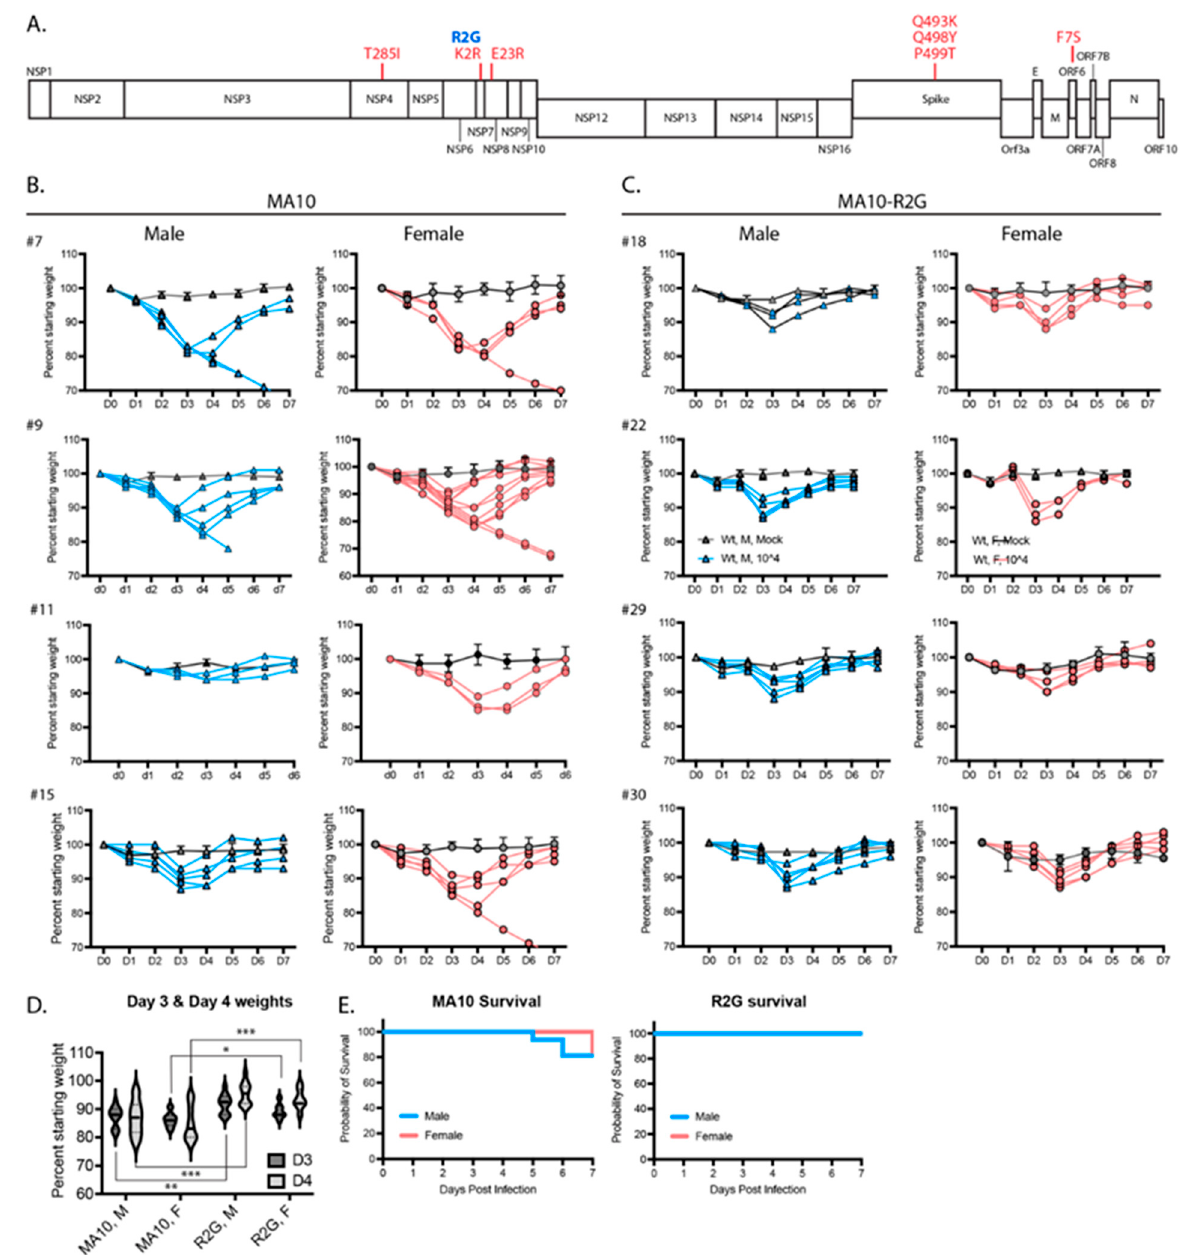
Figure 2. Comparison of SARS-CoV-2 MA10 and the R2G variant that was generated in our lab. ( A ) Schematic representation of the SARS-CoV-2 genome showing mutations found in MA10 (red) and in the R2G variant (blue) as compared to the original Wuhan isolate. ( B , C ) Weight loss in males (blue) and females (pink) infected with MA10 ( B ) or R2G ( C ). Four independent experiments are shown for each to demonstrate experiment-to-experiment variability/consistency. Data for mocks are shown as averages with 2–5 mice per cohort, while spaghetti plots are presented for each infected animal. ( D ) Violin plots of body weight for male (M) and female (F) animals three or four days post infection with either MA10 or R2G. Plots include all animals shown in ( B , C ) and significance was calculated using Welch’s t -test, where * is p ≤ 0.05, ** is p ≤ 0.01, and *** is p ≤ 0.001. ( E ) Survival curves for animals infected with MA10 or R2G as presented in ( B , C